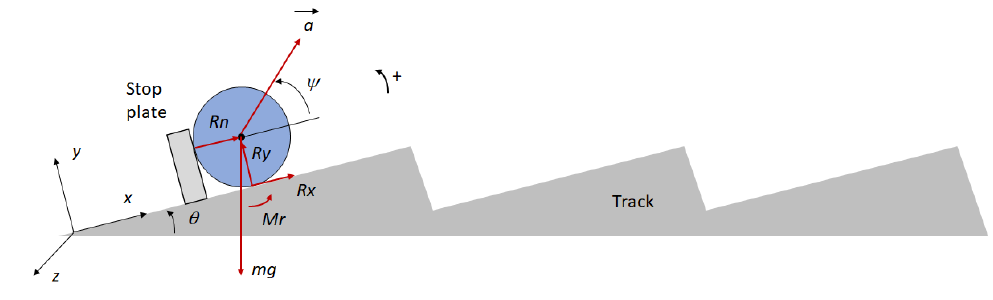
Figure 18. Conveyor with saw-teeth track.